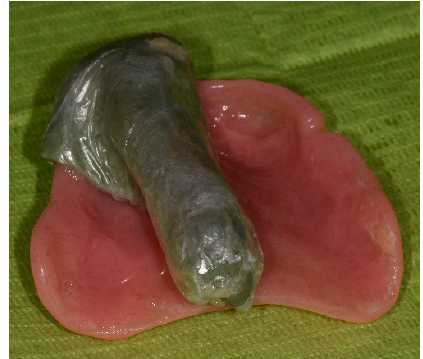
Figure 1. The self-fabricated clay obturator.